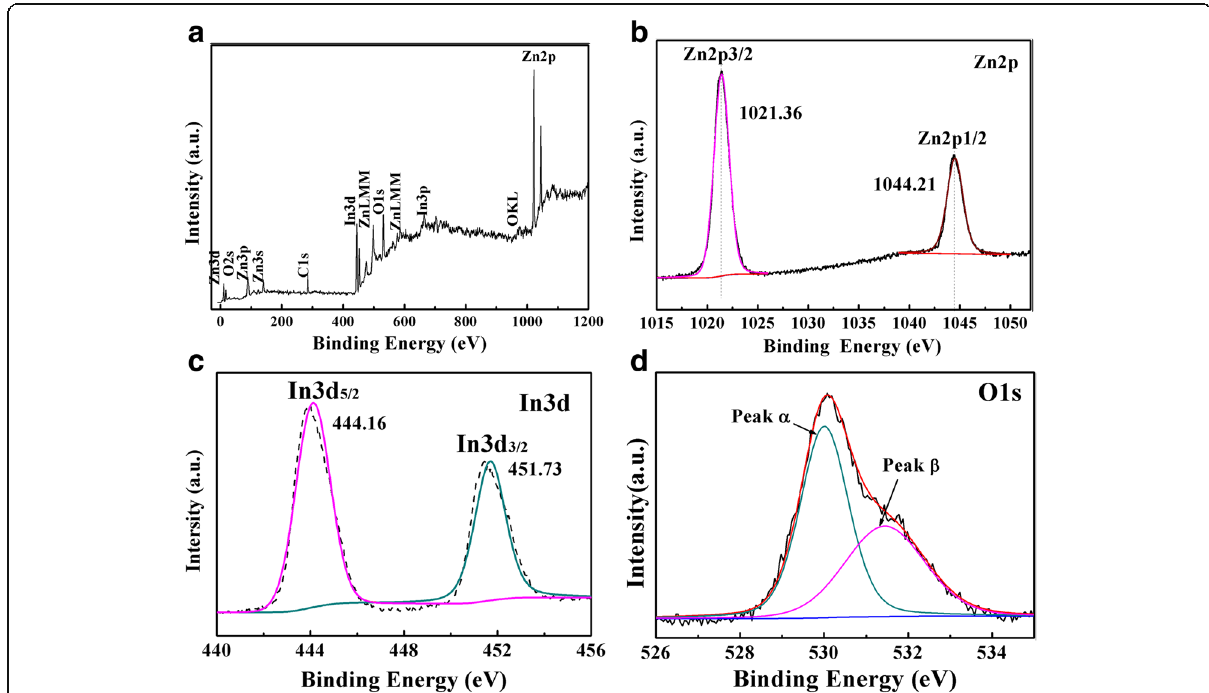
Fig. 4 XPS survey spectrum of Zn-In-4 and corresponding high-resolution XPS spectra: ( b ) Zn2p, ( c ) In3d and ( d ) O1s. The units of Fig. 4 ( a ),( b ),( d ) should be "Binding Energy" rather than "Banding Energy". The replaceable Fig. 4 ( a ), ( b ), ( d ) shown in